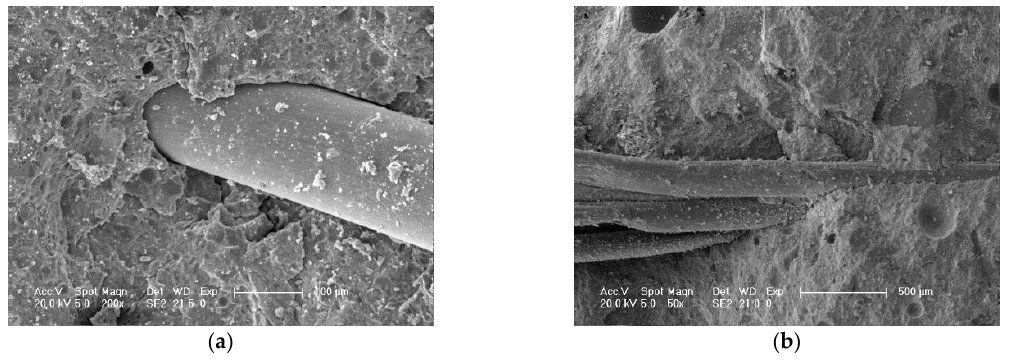
Figure 17. Microscopic picture of hybrid polypropylene-steel fiber RPC: ( a ) Interface transition zone between steel fiber and matrix and ( b ) steel fiber knot.